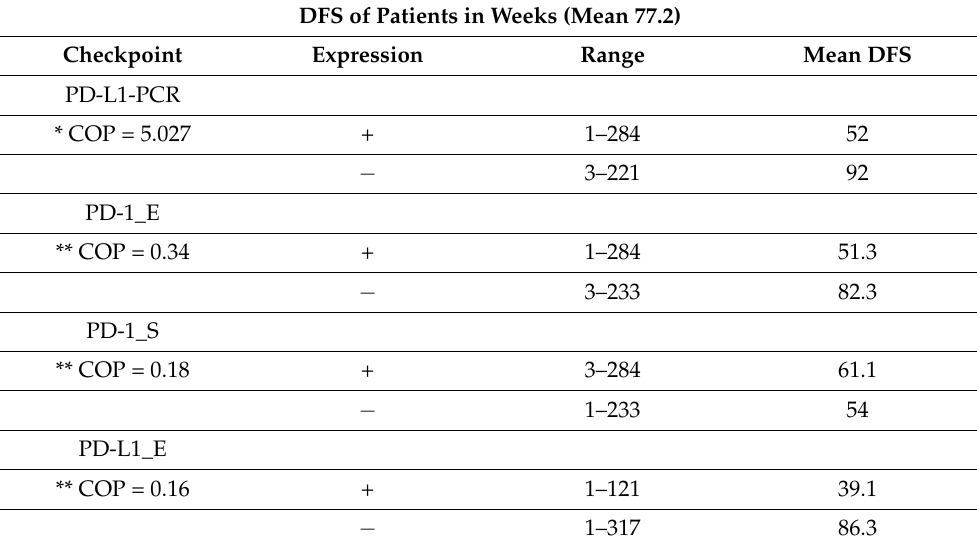
Table 6. Disease free survival of the patients in regard to overexpression or the different immune checkpoints.